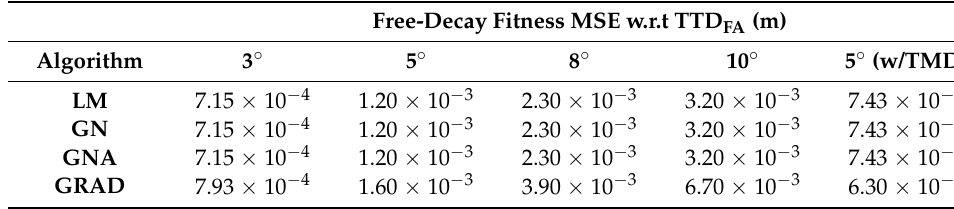
Table 3. Algorithm selection results.